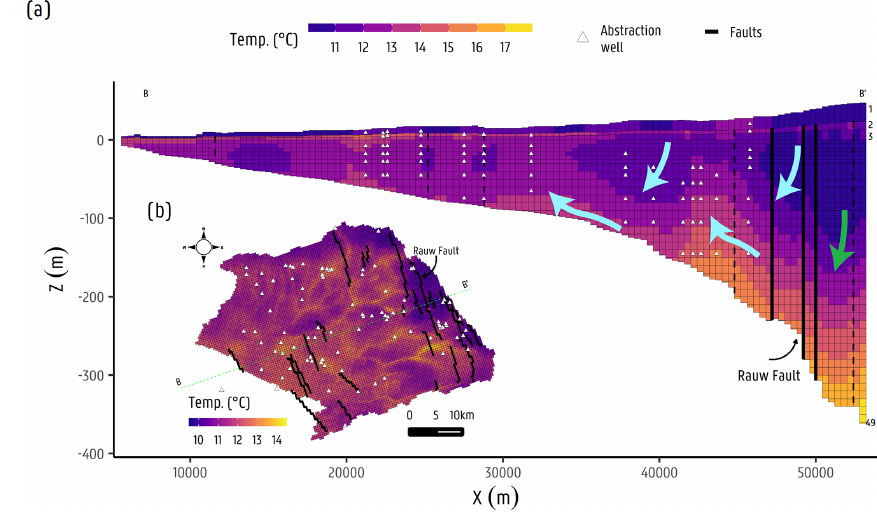
Figure 7. Temperature distribution at the last transport step for the paleo-temperature transport model in the (a) cross section. Green and cyan arrows indicate flow systems and fluxes on the east and west side of the Rauw fault (b) and the plan view from model layer 10, indicating a cross section (B–B’) for panel (a)